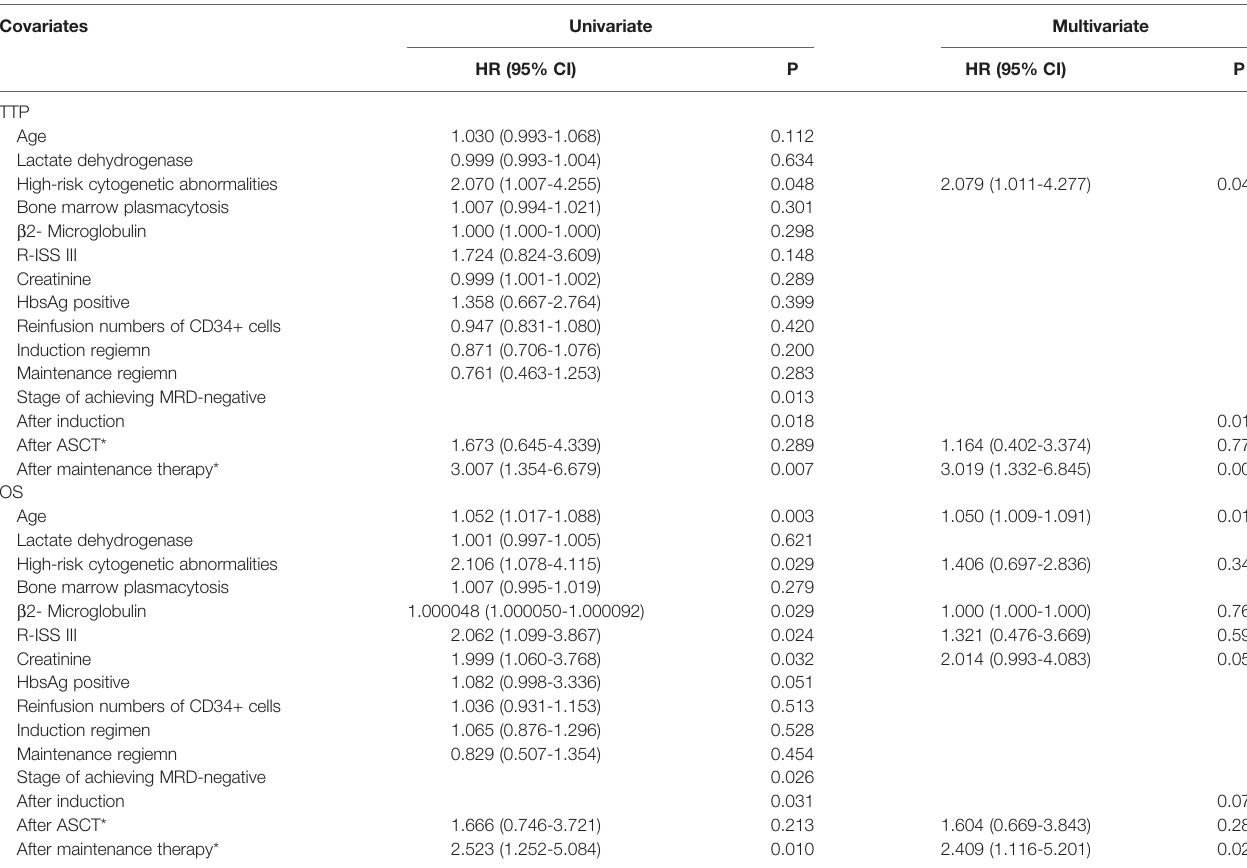
TABLE 3 | Univariate and multivariate analyses of TTP and OS for enrolled patients.